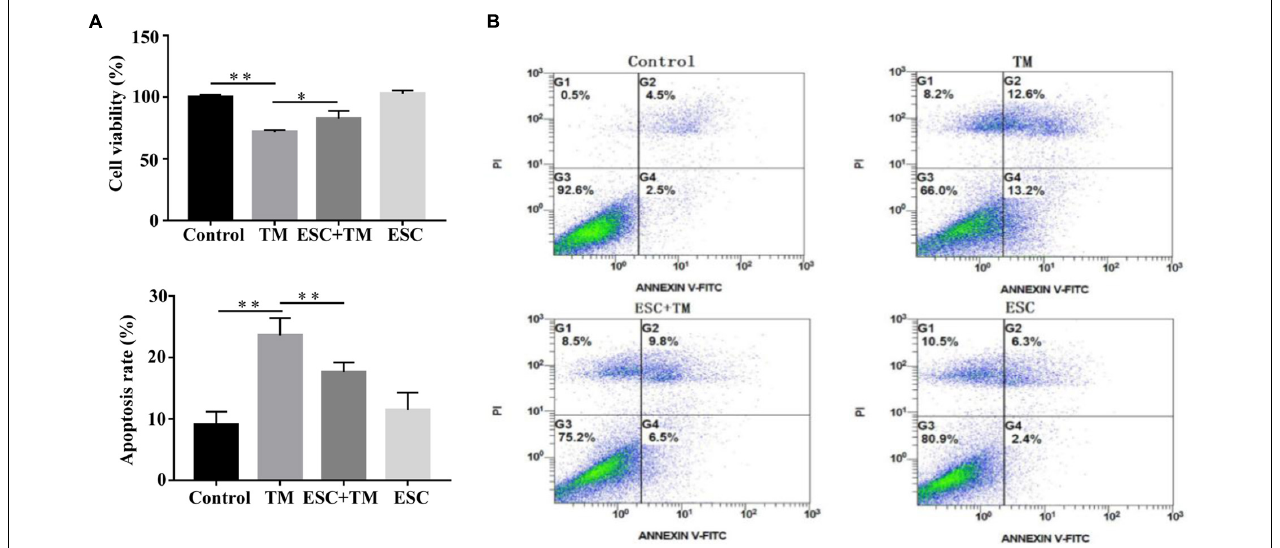
FIGURE 1 | Escitalopram (ESC) enhanced viability of bEnd.3 cells induced by tunicamycin (TM). (A) The effect of ESC on viability of bEnd.3 cells. Cell viability assays of bEnd.3 cells were measured by CCK8. (B) The effect of ESC on apoptosis of bEnd.3 cells. Apoptosis levels of bEnd.3 cells was analyzed by Annexin V-FITC/PI double-staining. Data are presented as mean ± SD. * p < 0.05. ** p < 0.01.